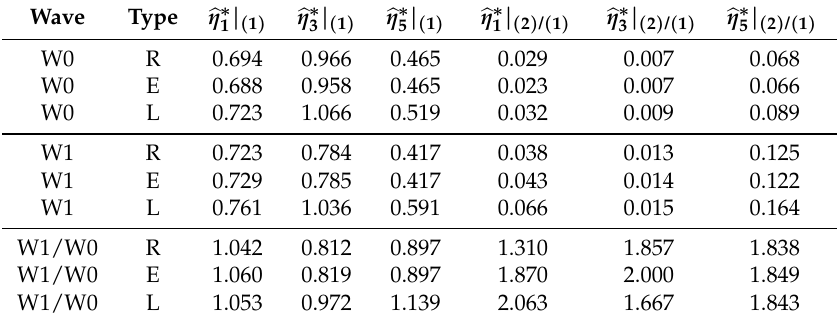
Table 8. Prototype scale motion amplitude response for the moored WEC. order amplitude of motion mode i . Simulation types are headlined: R for RANS; E for Euler; and L for linear. See Table 4 for non-dimensionalisation factors.